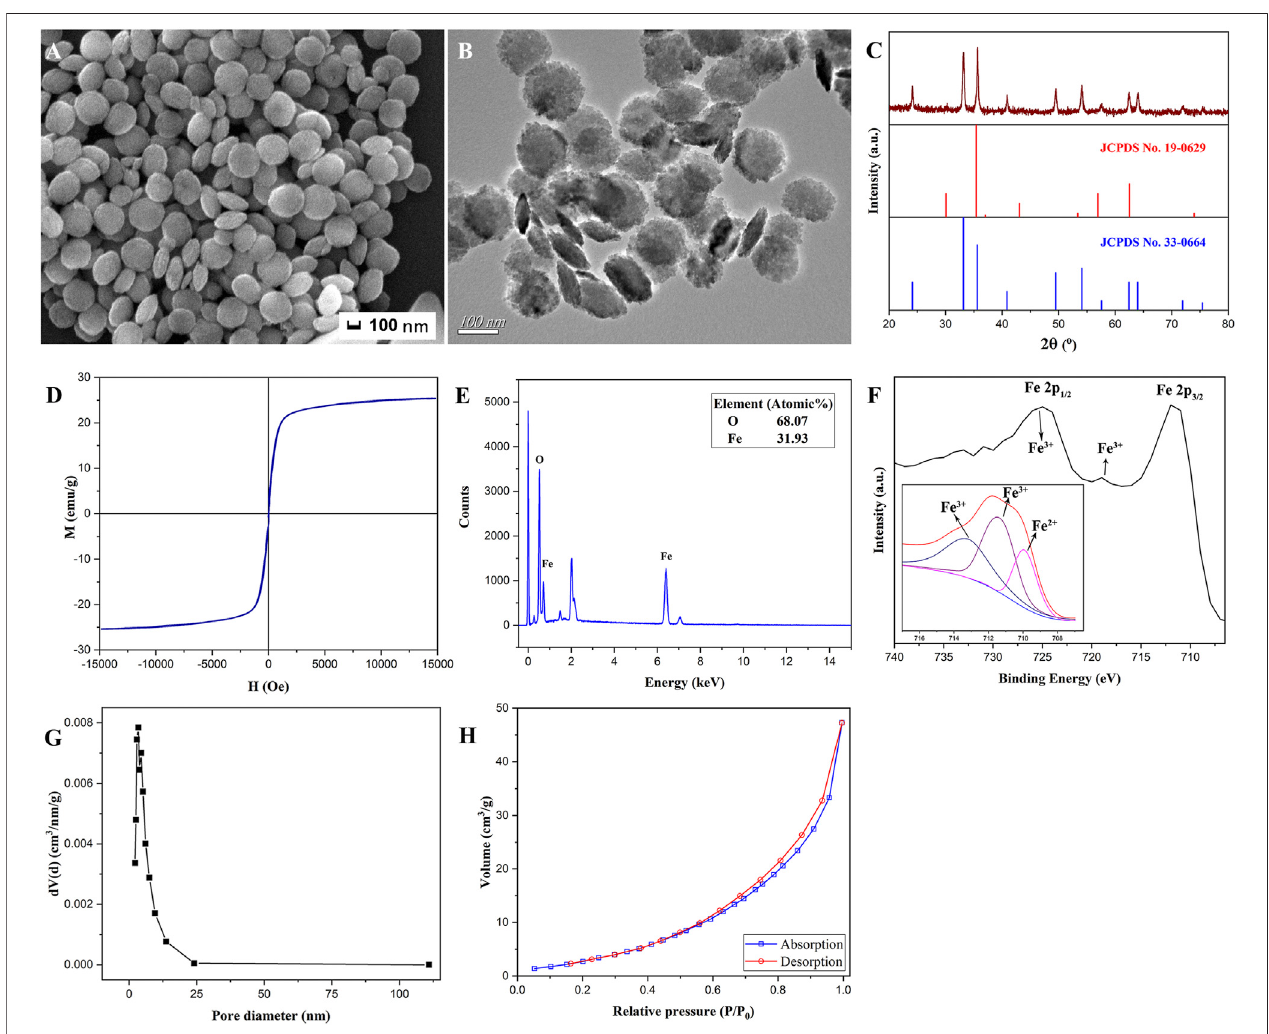
FIGURE 2 | The scanning electron microscopy (SEM) morphology (A) , transmission electron microscopy (TEM) image (B) , x-ray diffraction (XRD) pattern (C) , hysteresis loops (D) EDS spectrum (E) , x-ray photoelectron spectroscopy (XPS) spectrum (F) , the chart of pore diameter distributions (G) , and N 2 adsorption and desorption diagram (H) of magnetic α -Fe 2 O 3 /Fe 3 O 4 heterogeneous nanosheets.